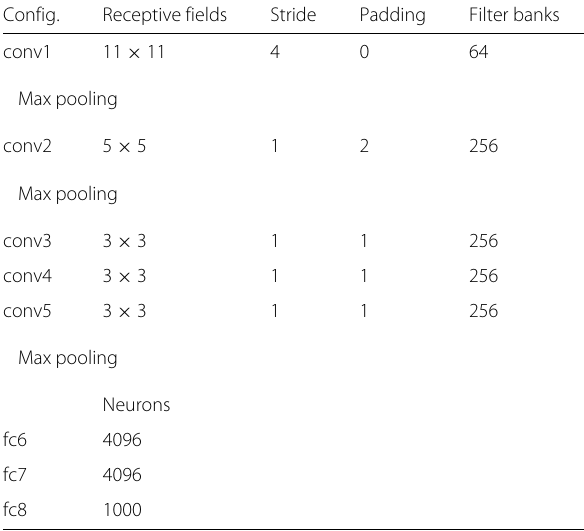
Table 1 The configuration of imagenet-vgg-f. conv i denotes the i -th convolutional layer